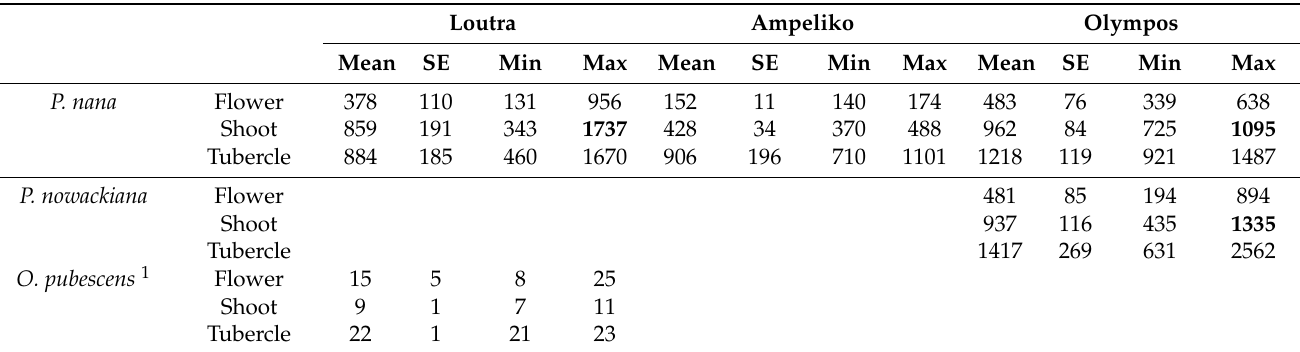
Table 1. Ni concentration (mg.kg − 1 ) in different plant parts (flower, shoot, and tubercle) of the three broomrape species sampled from serpentine sites (Loutra, Ampeliko, Olympos) of the island of Lesbos, Greece. Mean ( ± 1 Standard Error, SE), minimum and maximum values are presented. Numbers in bold indicate maximum Ni concentrations exceeding the hyperaccumulation threshold (1000 mg.kg − 1 ) in above-ground tissues.